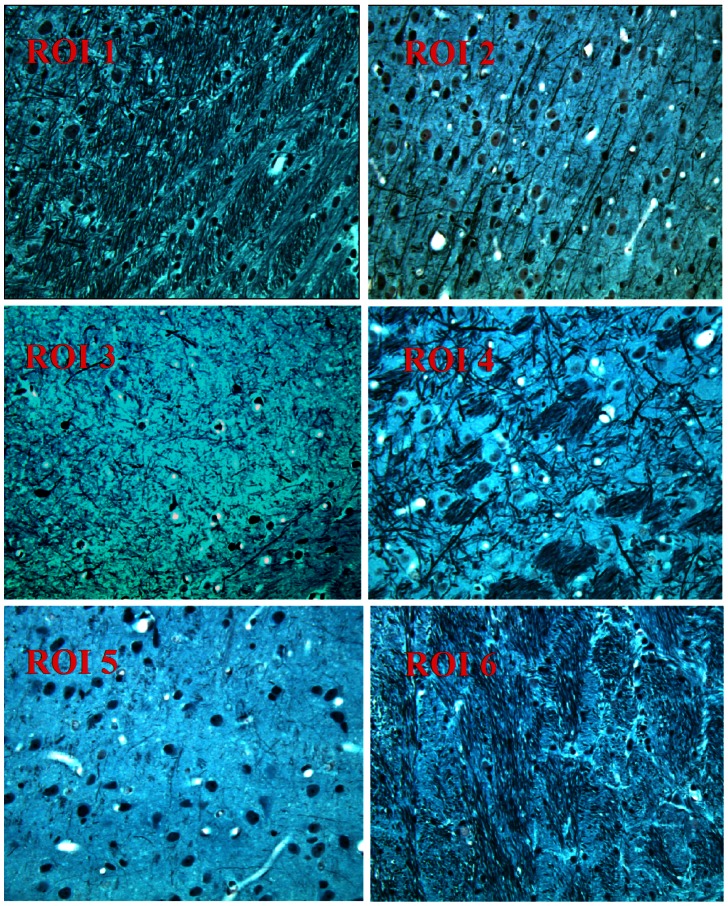
Histological details in selected ROIs in contralateral side of the brain.ROI 1: external capsule; ROI 2: prim somatosensory cortex; ROI 3: hippocampus; ROI 4: internal capsule; ROI 5: insular cortex; ROI 6: striatum were listed from up left (ROI 1) to bottom right (ROI 6) [31].